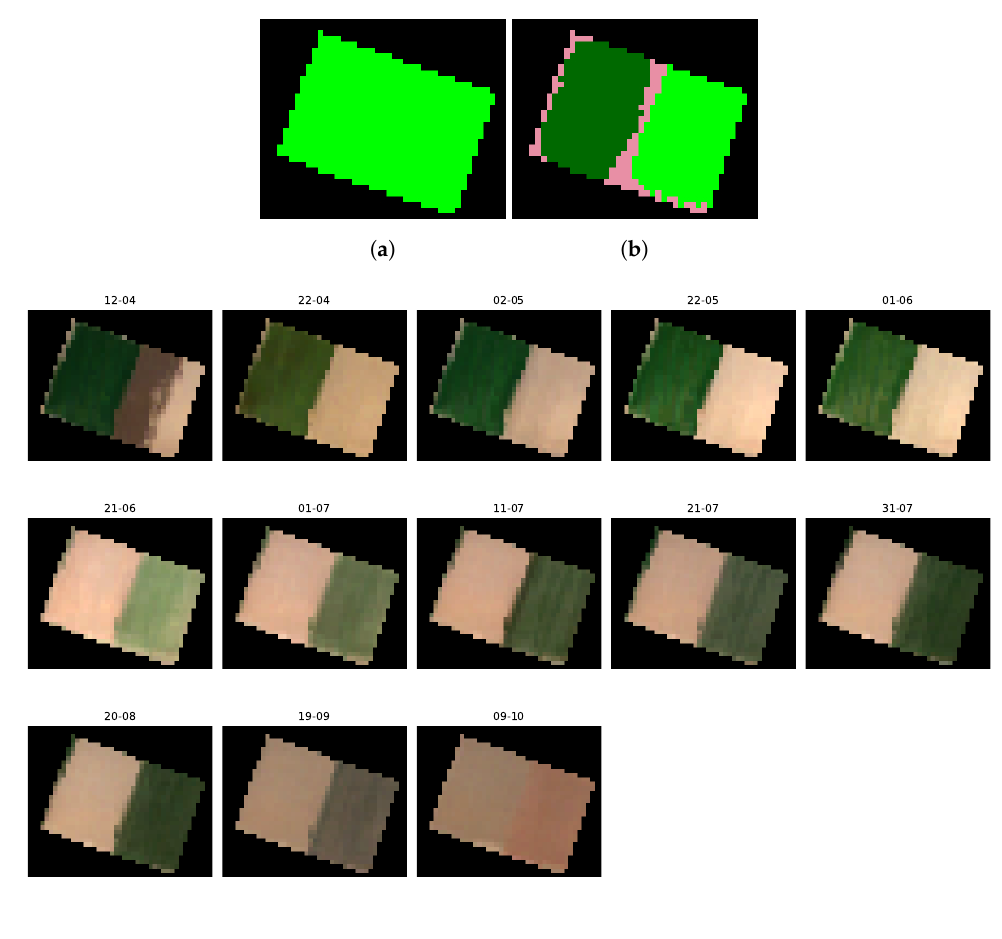
Figure 18. Comparison between the ground truth and candidate classes image of the second mis-split field, alongside multitemporal Sentinel-2 imagery of the parcel. ( a ) Ground truth class image of the mis-split field n°2. ( b ) Candidate classes image of the mis-split field n°2. ( c ) Sentinel-2 imagery of the second detected mis-split